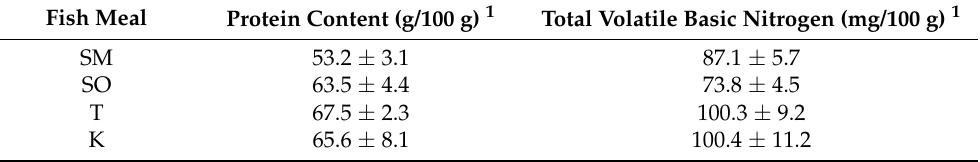
Table 1. Protein and total volatile basic nitrogen contents of fish meal samples from feed mills. Fish Meal Protein Content (g/100 g)